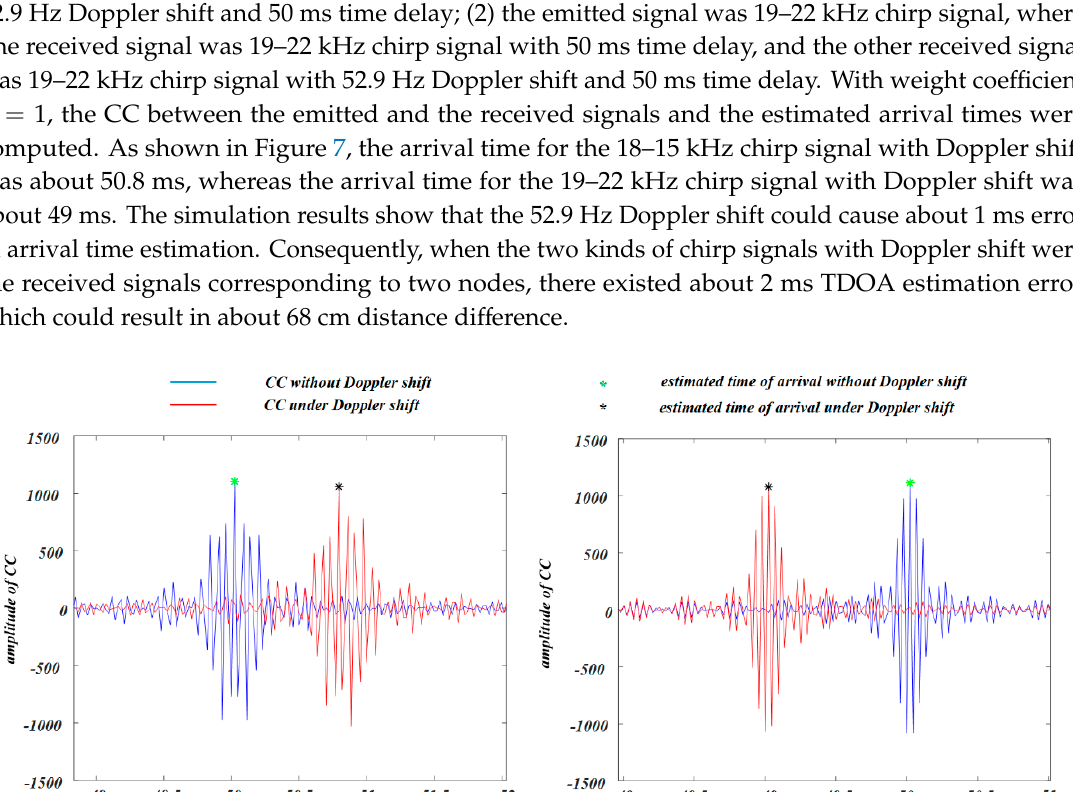
Figure 6. Diagram of positioning correction.